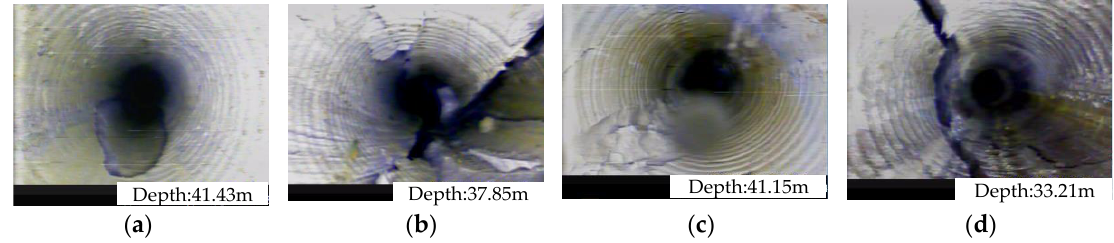
Figure 8. Drilling peep results of the station: ( a ) and ( b ) are results of the first station; ( c ) and ( d ) are results of the second station.